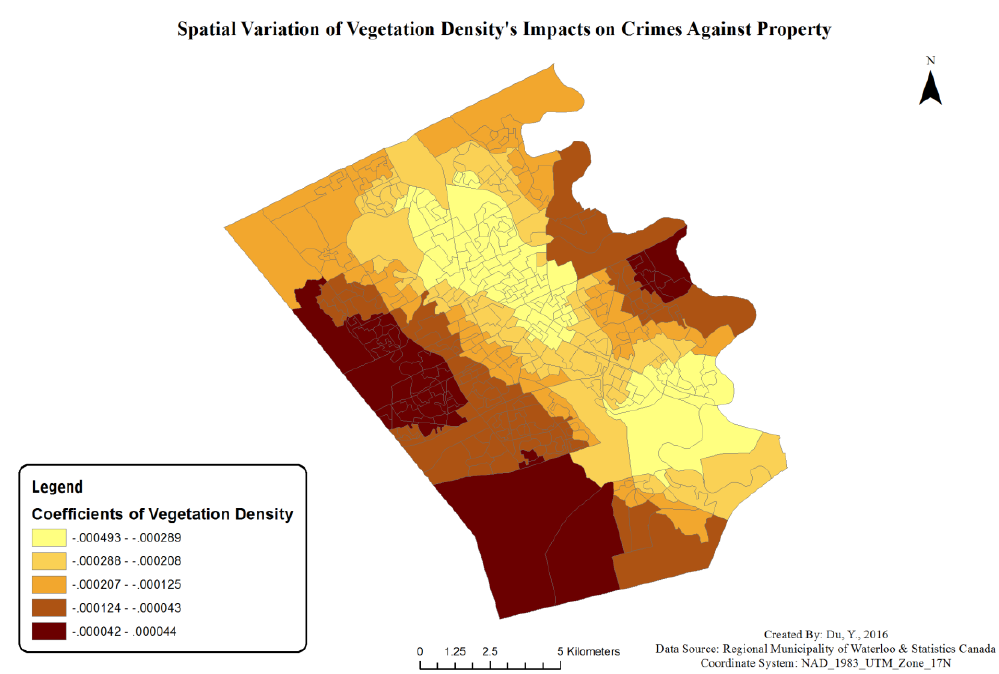
Figure 8. Vegetation density’s impact on crimes against property.